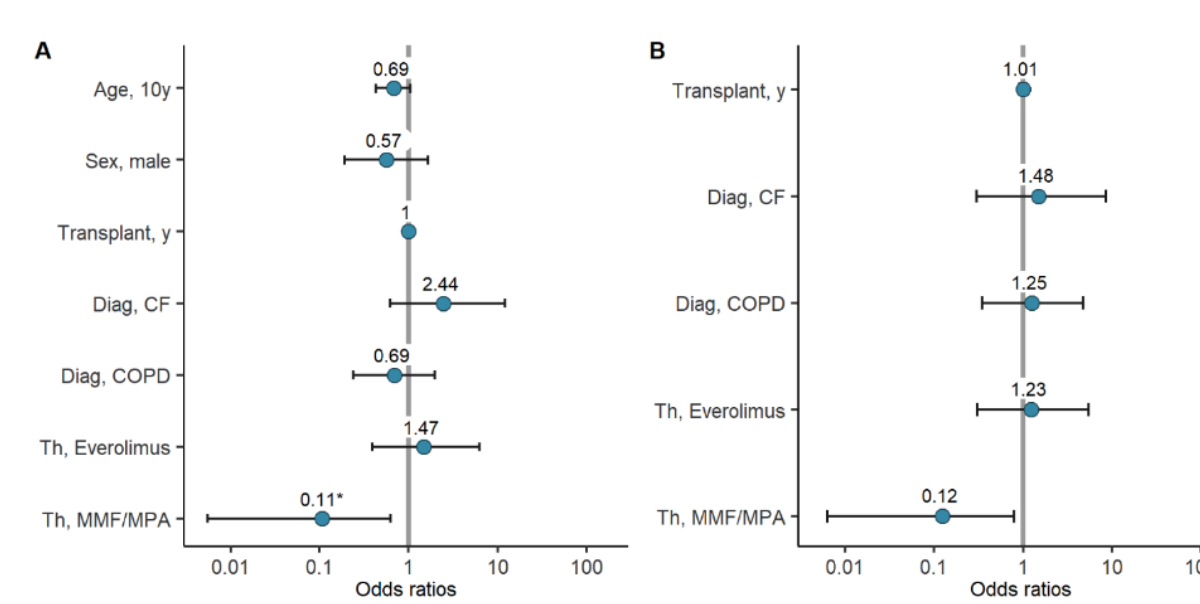
acid), each adjusted for age and sex.